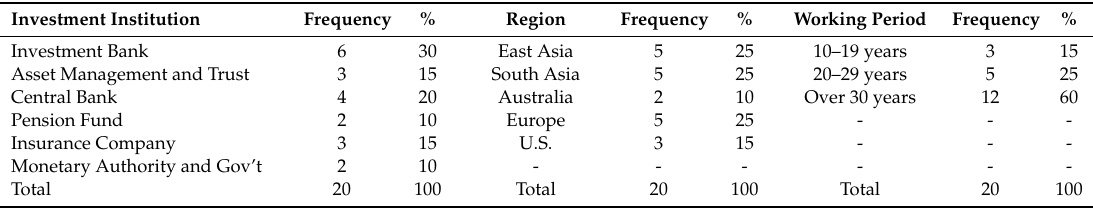
Table 4. Distribution of survey respondents by